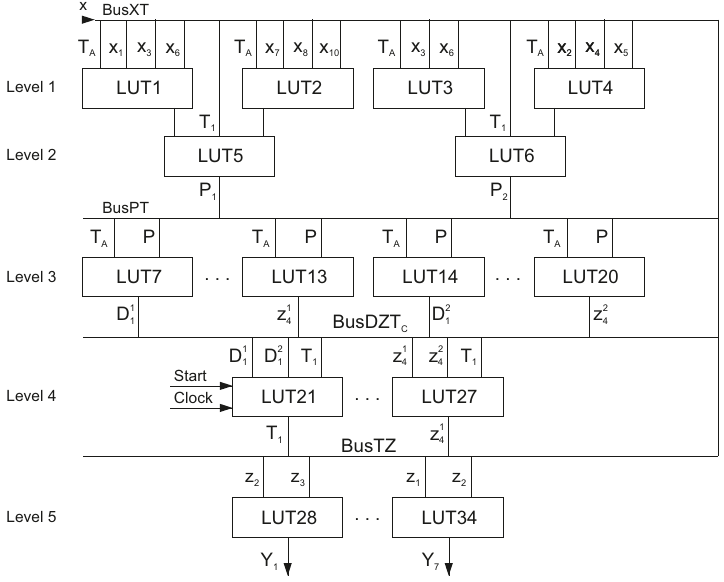
Figure 8. Logic circuit of Mealy FSM MP C Y ( S 0 )